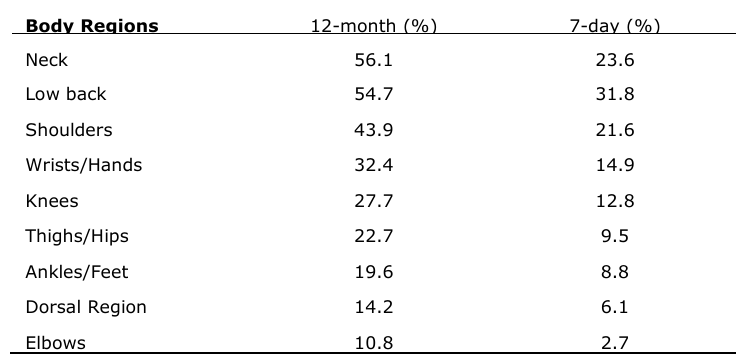
Table 1. Prevalence (12-month and 7-day) of musculoskeletal symptoms by body region